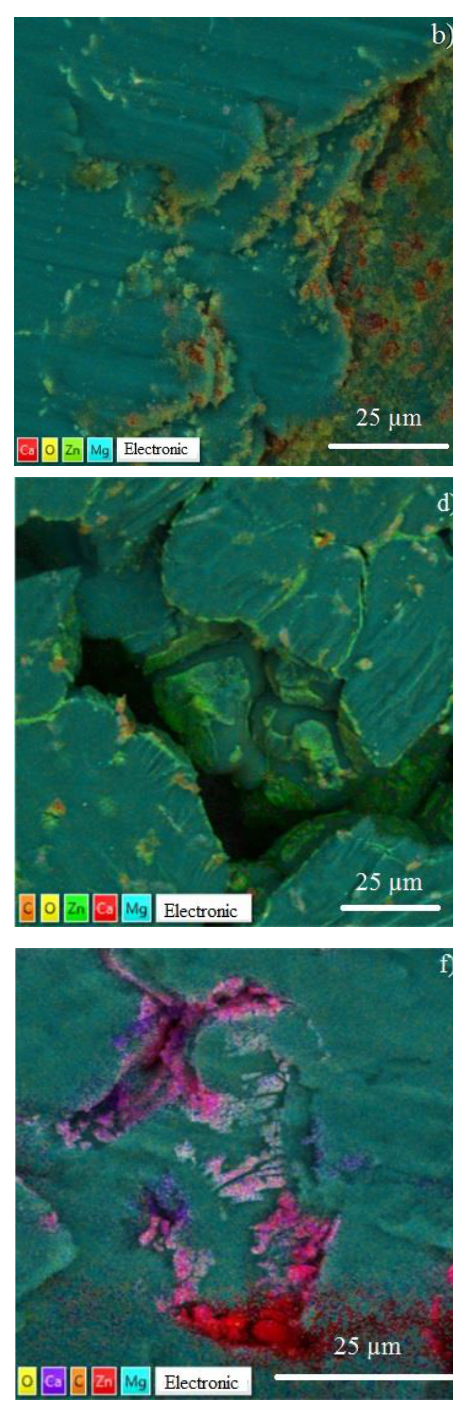
Figure 7. SEM image of the fracture surface of magnesium alloys Mg – Ca – Zn reference ( a , b ), Mg –